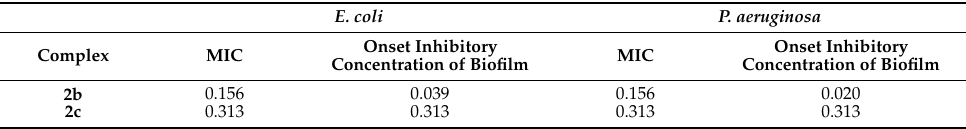
Table 3. Determination of the onset inhibitory concentration (mM) of biofilm formation for complexes 2b and 2c in comparison to MIC